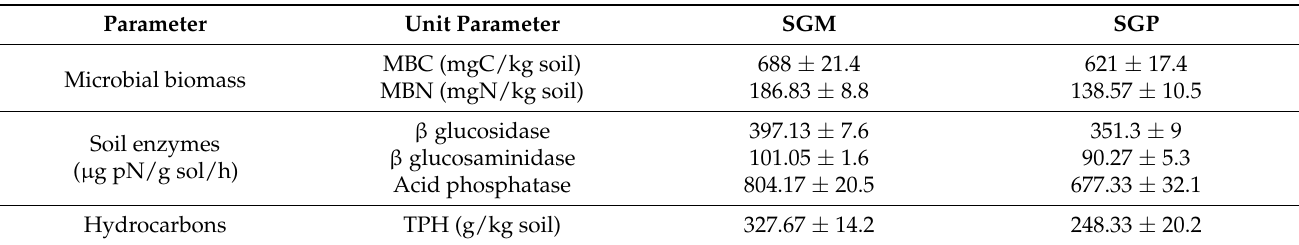
Table 5. Soil microbial biomass and